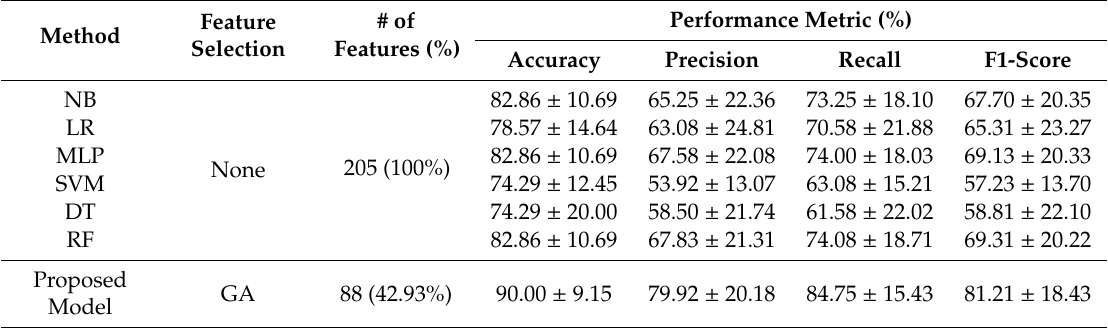
Table 7. Performance comparison of several classification models for dataset I (multi-class).